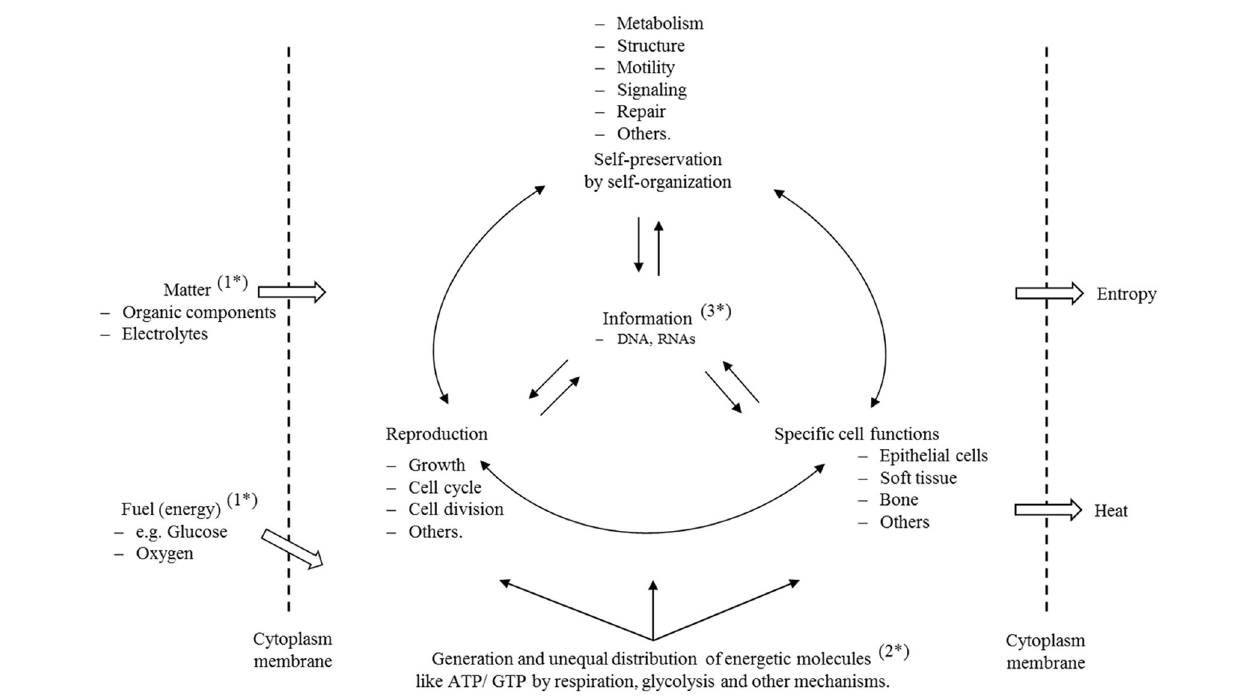
FIGURE 1 | Self-preservation and reproduction are the fundamental characteristics of cells. To preserve all structures and functionalities, the cell must ingest matter (1*) to generate structural and functional, as well as specific energetic, molecules (2*). To meet these highly sophisticated properties, life has developed, through an evolutionary process, a molecular information system (3*) that guarantees structure, ordered processes, and a safe transfer of information from generation to generation. The scheme illustrates that matter, energy and information depend reciprocally on each other and, on this basis, it is clear that disturbance of any one of those properties must have consequences for the others. A cell is a thermodynamic, open system that is far away from equilibrium. For this reason, it displays a lower entropy state than the environment. Furthermore, we have to assume that entropy is not equally distributed, and that the complete entropy of a cell is in fact a sum of many different individual states. Disturbance of individual molecular mechanisms and structures has different consequences to the cell, but, if they are important enough and reach a state of irreversibility that cannot be repaired or compensated, then the cell enters a metastable state with all of the consequences that are explained in this